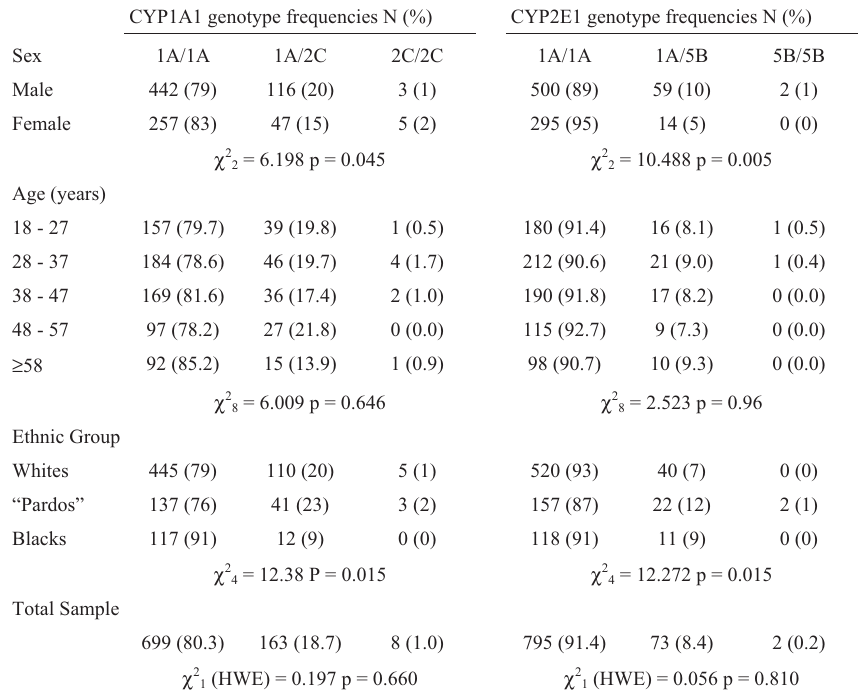
Table 2 - Allele frequencies of Cyp1A1 ( exon 7 ) and CYP2E1 ( Pst I ) in different ethnic groups.